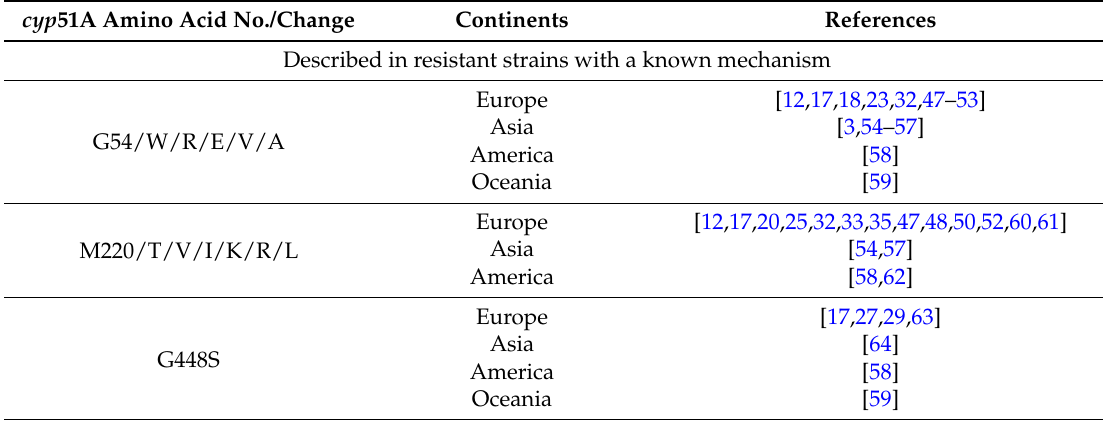
Table 1. Described Aspergillus fumigatus cyp 51A